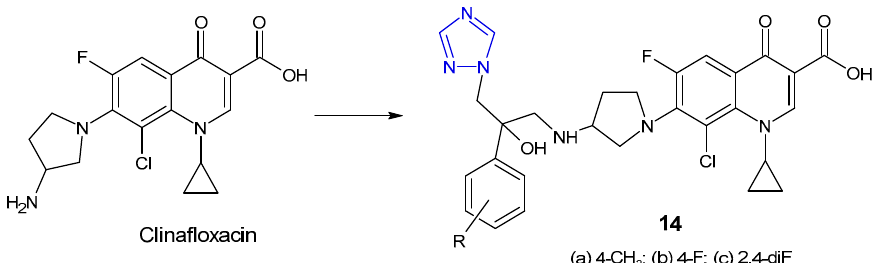
Figure 7. 1,2,4-triazole analogues of clinafloxacin.